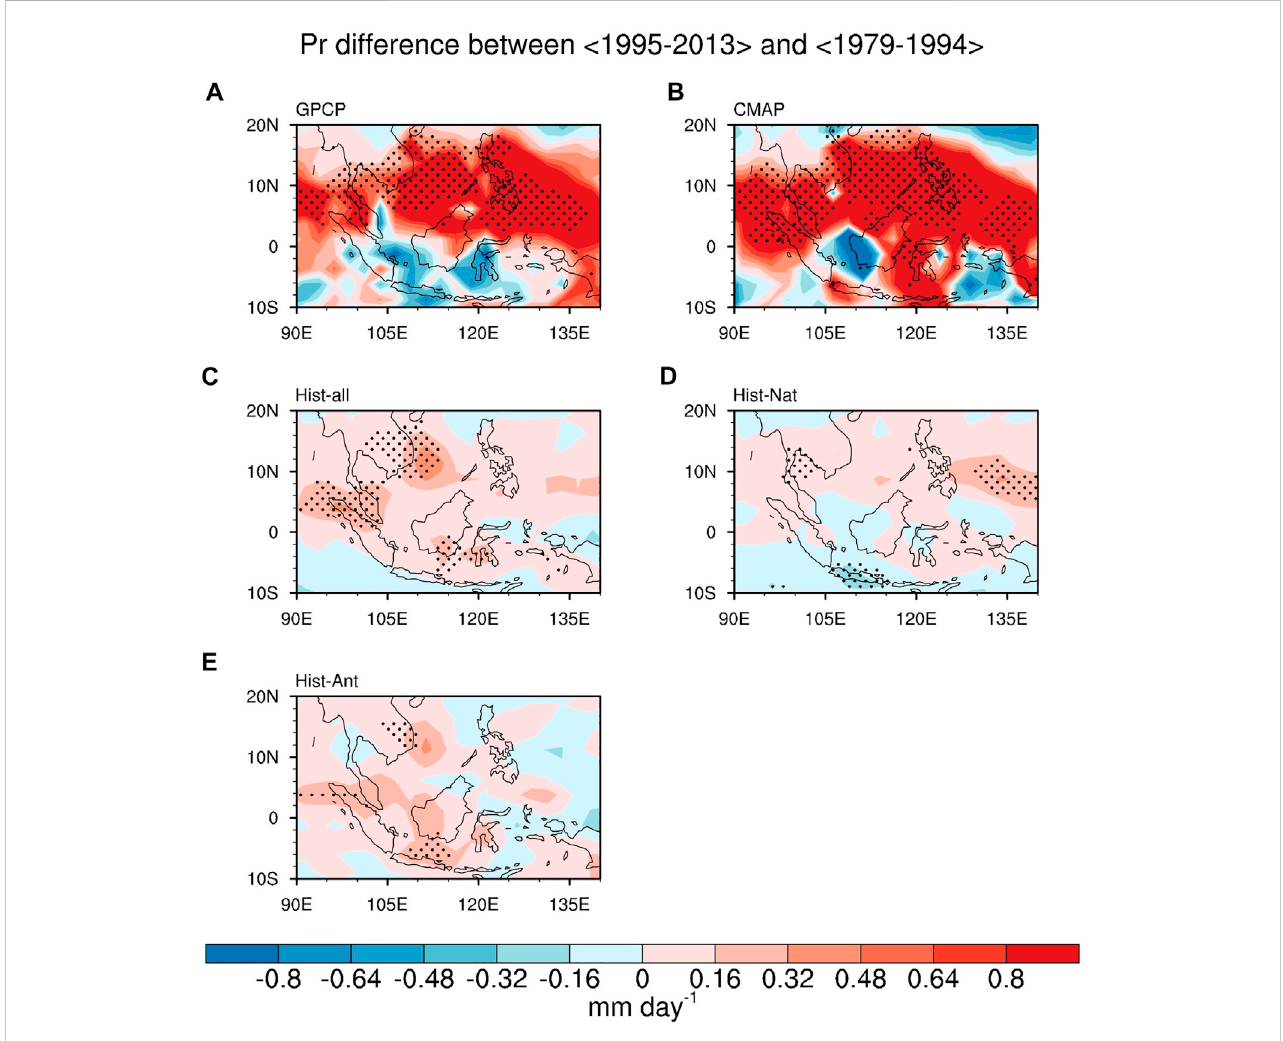
FIGURE 8 Thedifferencesofprecipitationanomalies(shading,SI=0.16 mm day − 1 )overSoutheastAsiabetween1995 – 2013and1979 – 1994in (A) GPCP, (B) CMAP, (C) Hist-all, (D) Hist-Nat, and (E) Hist-Ant MME, respectively. Values exceeding the 90% con fi dence levels based on the two-tailed Student ’ s t -test are drawn with black